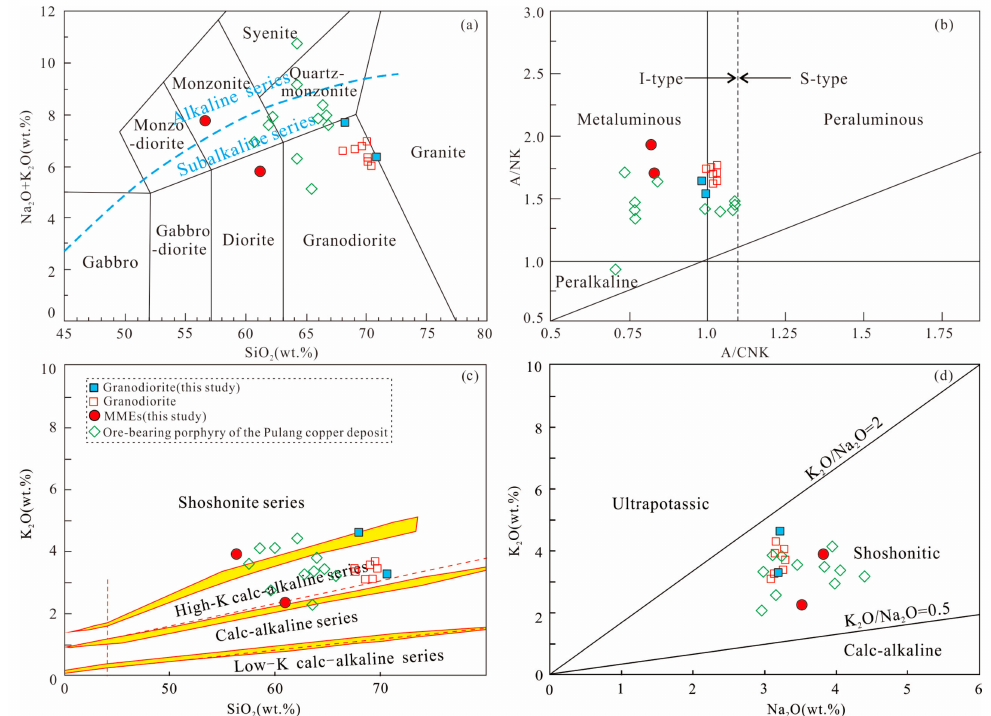
Figure 3. Geochemical classification diagrams for granodiorite and MMEs. ( a ) Total alkaline-silica diagram [39]; ( b ) A / NK vs. A / CNK diagram [40]; ( c ) K 2 O vs. SiO 2 diagram [41] and ( d ) K 2 O vs. Na 2 O diagram. Note: Data for granodiorite is from [17,18] and data for ore-bearing porphyry of the Pulang copper deposit is from